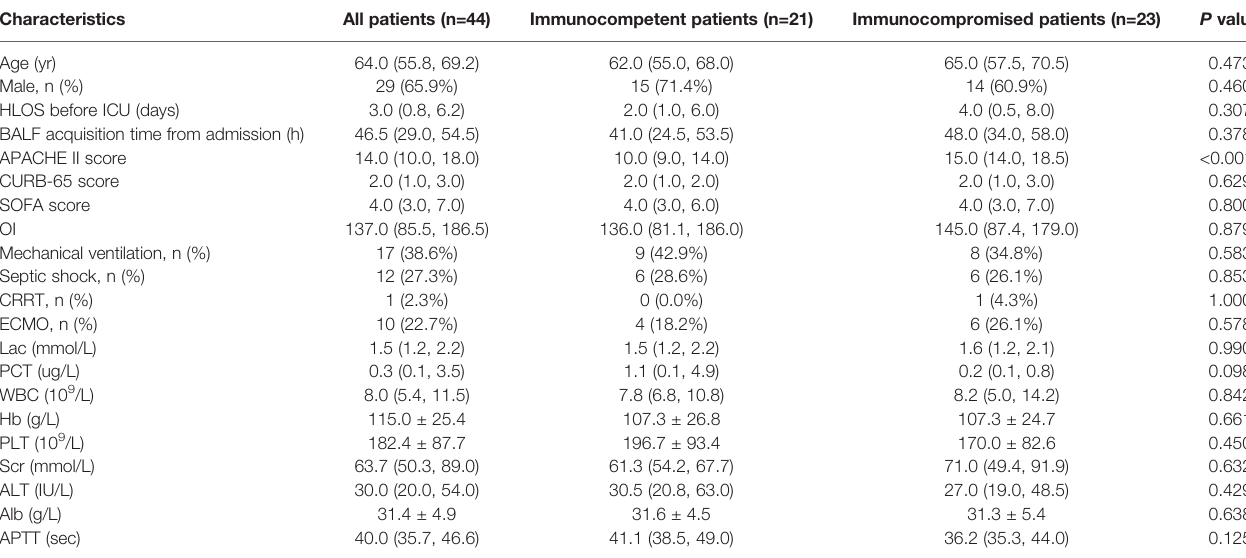
TABLE 1 | Patient characteristics and baseline of two groups.